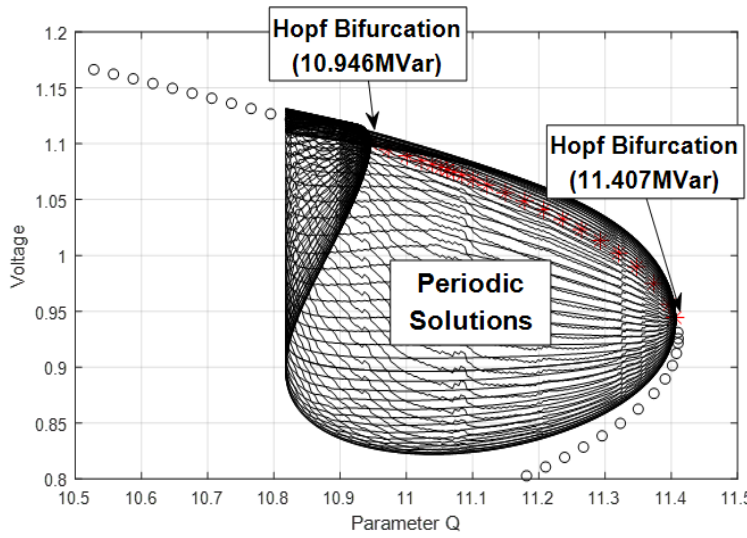
Figure 7. A bifurcation diagram of sample power system.